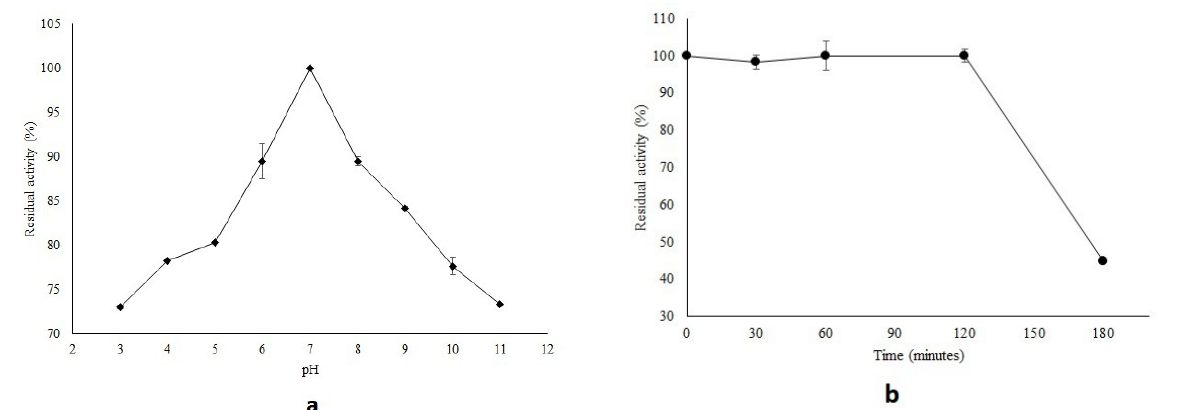
Figure 3. a - Effect of pH on enzyme activity. b - Stability of enzyme activity at pH 7,0.